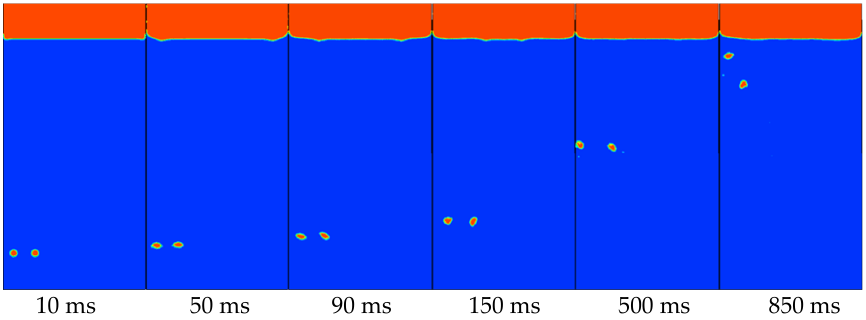
Figure 18. The shape change of the rising double bubbles arranged horizontally near the wall. Figure 19 shows the flow field distribution of the bubble at 90 ms. It can be found that the deflection of the left bubble is slightly smaller than that of the right bubble. This is because the inducement of the deflection of the left bubble is that the influence of the wall surface is more obvious than the influence between the bubbles, and the jet formed on the wall promotes the deflection of the left bubble; The right bubble is the bubble deflection caused by the interaction between the bubbles, so compared with the two, the right bubble deflection is greater.